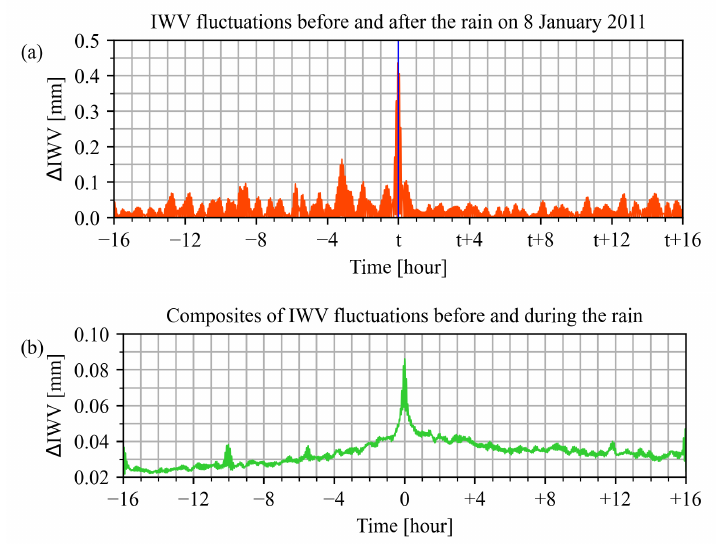
Figure 4. ( a ) IWV fluctuation series 16 h before and after a rain event between 02:11 UT and 07:05 UT on 8 January 2011 (red). The blue vertical line represent the occurrence/duration time of rain. ( b ) Composite of IWV fluctuation series of 759 rain events 16 h before and during rain (green).